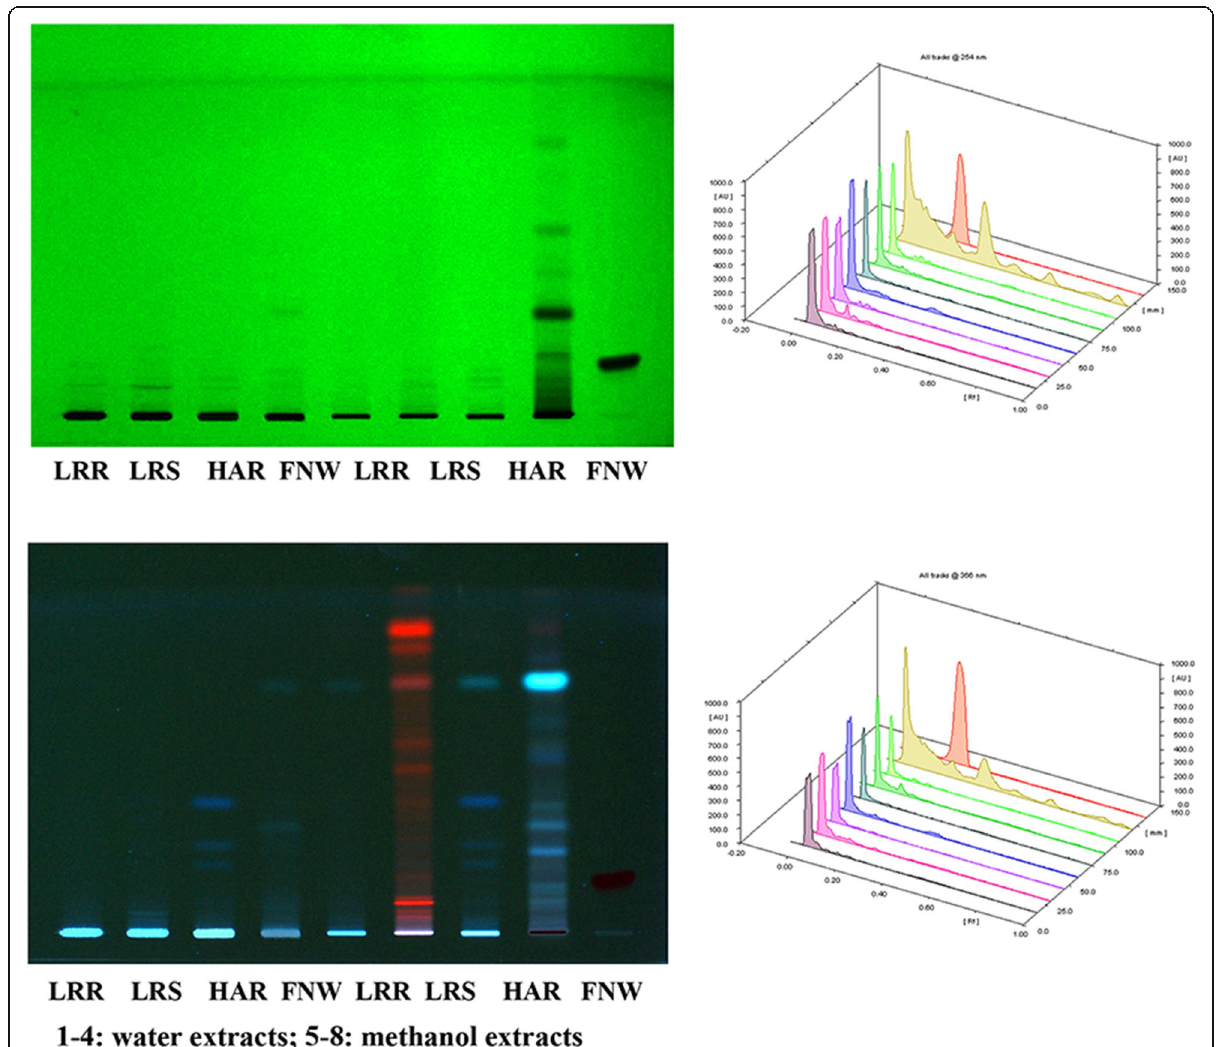
Fig. 3 HPTLC profile of crude methanol and aqueous extracts of various Jivanti source plants